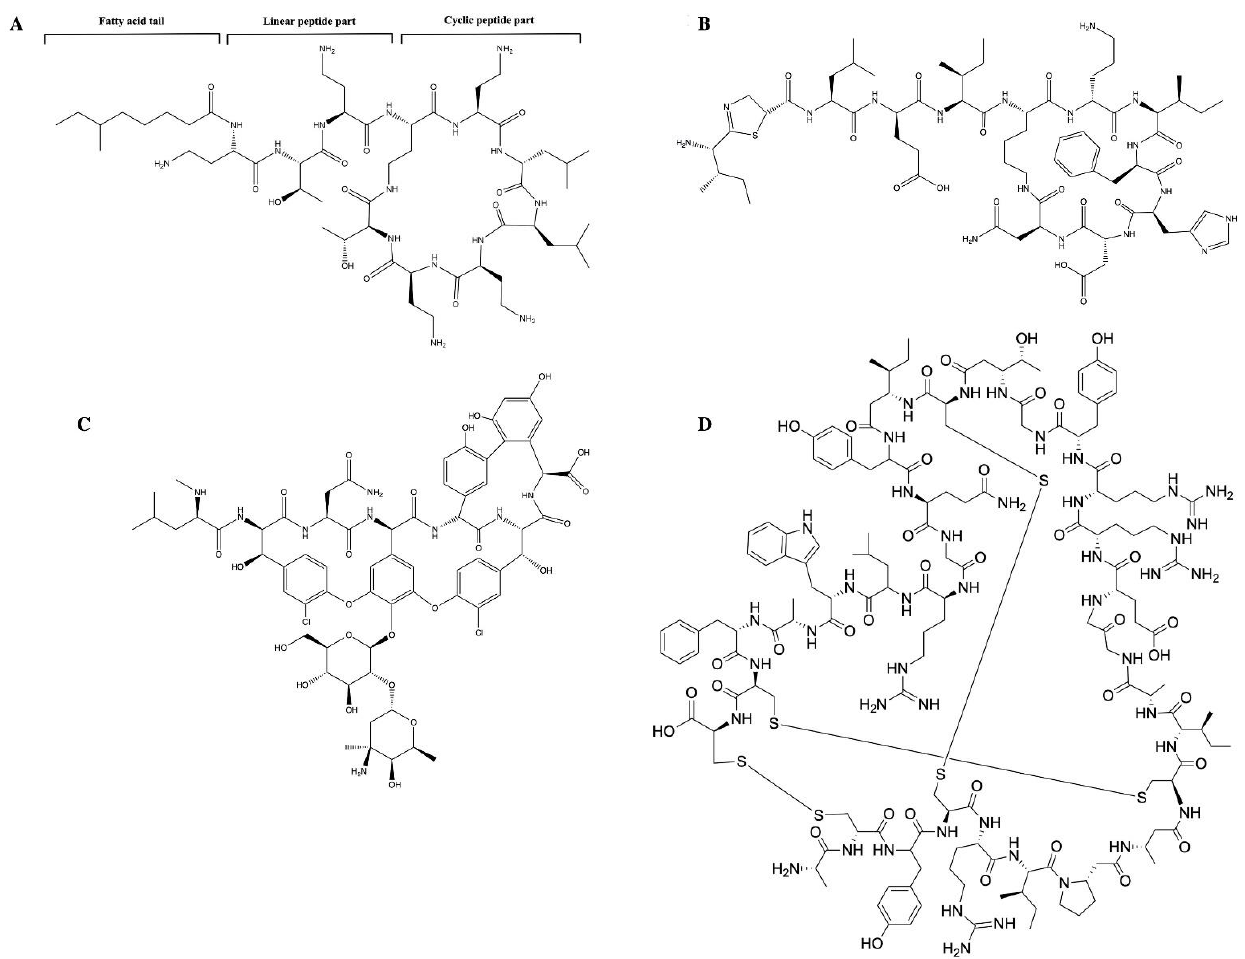
Figure 2. Chemical structure of cyclic antimicrobial peptides: ( A ) Structure of polymyxin B, including fatty acyl tail, linear peptide, and cyclic peptide ( B ) Chemical structure of bacitracin: bacitracin is an AMP that consists of D-aspartic acid, D-phenylalanine, D-ornithine, D-glutamic acid, and a ring of thiazoline containing amino acids. ( C ) Chemical structure of vancomycin: vancomycin is a branched tricyclic glycosylated non-ribosomal peptide. ( D ) Chemical structure of defensin: defensins comprise an N-terminal β -strand followed by an α -helix and two more β -strands. The β -strands form a triple- stranded antiparallel β -sheet that can be stabilized by disulphide bonds. Two of the disulphide bonds connect the α - helix and the central β -strand, while a third disulphide bond stabilizes the structure by linking the β -strand.